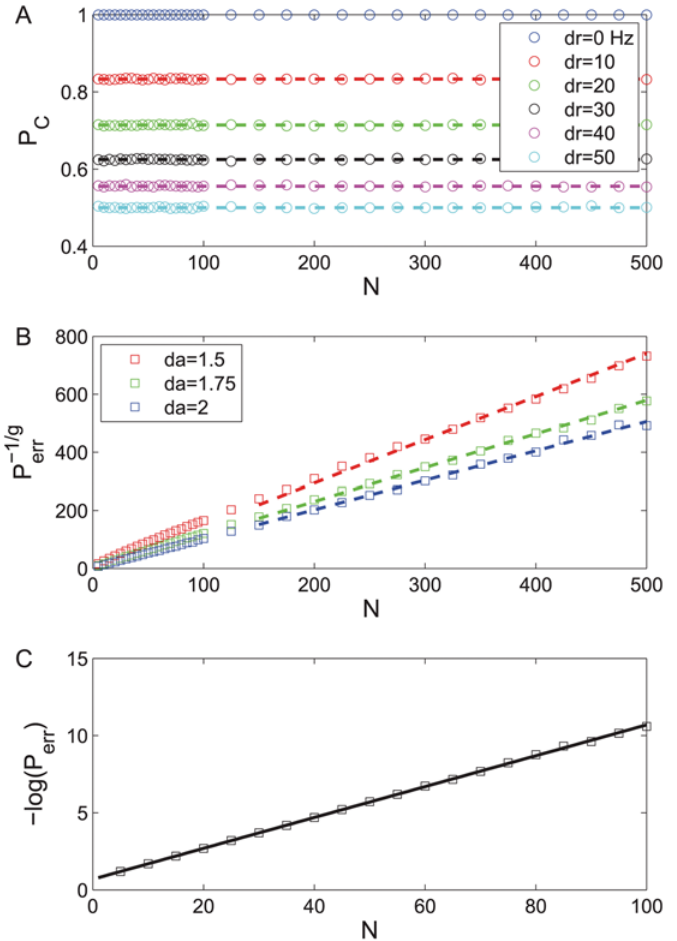
~ 0,0 : 2 ... 1 from top to bottom. The dashed r 0 ð Þ ~ a dh ð Þ { 1 . The dashed lines show linear e where g a 0 ð Þ